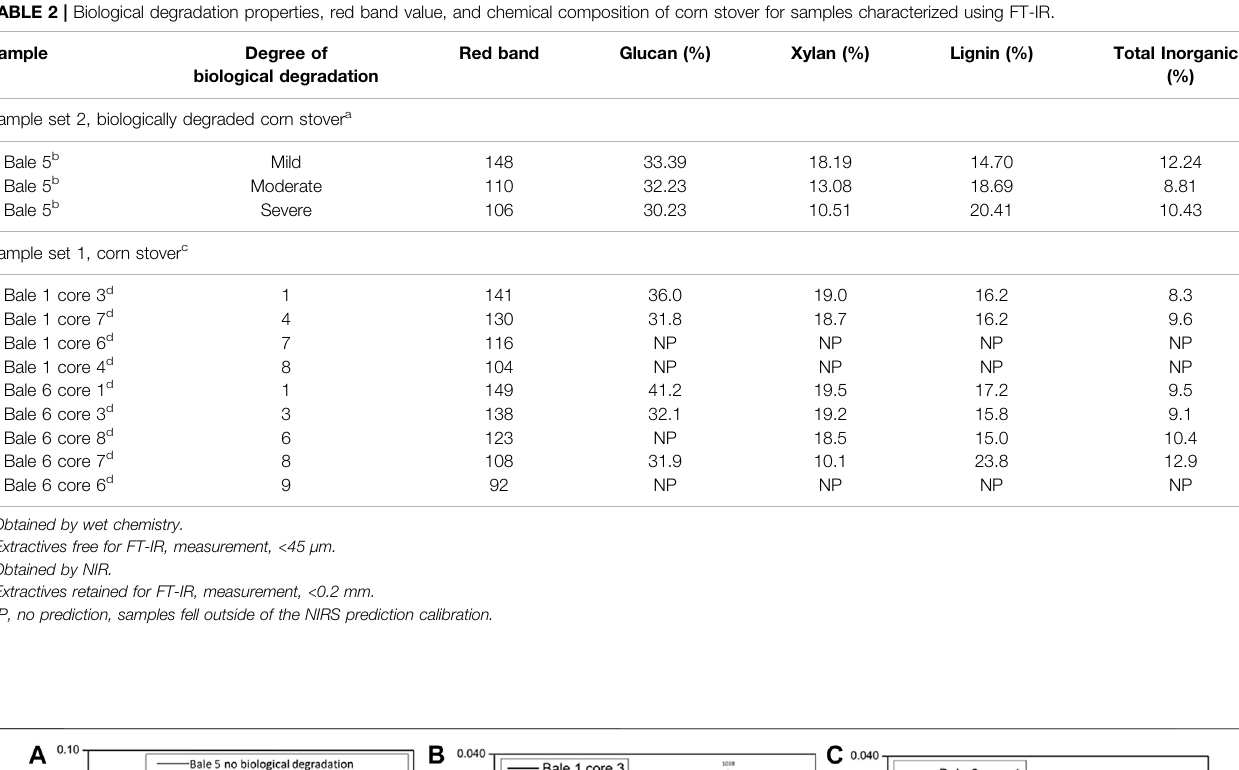
Frontiers in Energy Research |